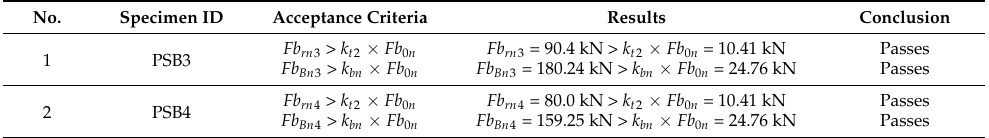
Figure 14. Results of negative bending moment test. ( a ) Test load for first crack (PSB3); ( b ) Test load for first crack (PSB4); ( c ) Maximum test load (PSB3); ( d ) Maximum test load (PSB4). Table 5. Results of negative bending moment tests for PSB3 and PSB4. Table 5. Results of negative bending moment tests for PSB3 and PSB4.